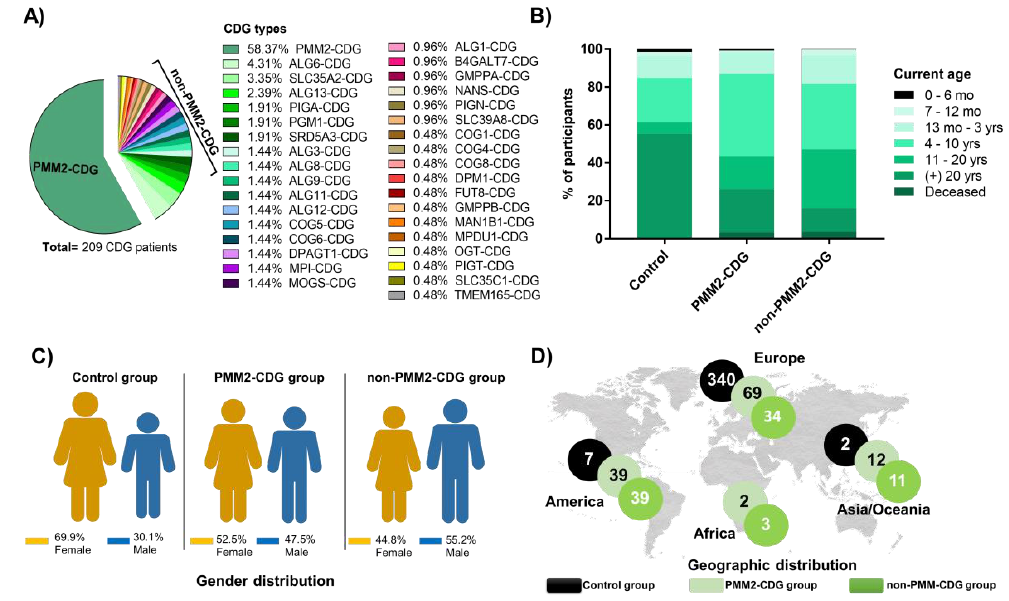
Figure 1. Characteristics of the ImmunoCDGQ (PMM2-CDG and non-PMM2-CDG groups) and ImmunoHealthyQ (control group) participants. ( A ) CDG distribution. CDG are listed in descending order according to their prevalence in the ImmunoCDGQ; ( B ) Age distribution of participants at the time of participation in the study; ( C ) Gender distribution of the study participants. Females are represented in yellow and males in blue; ( D ) Geographic distribution of participant per continent.